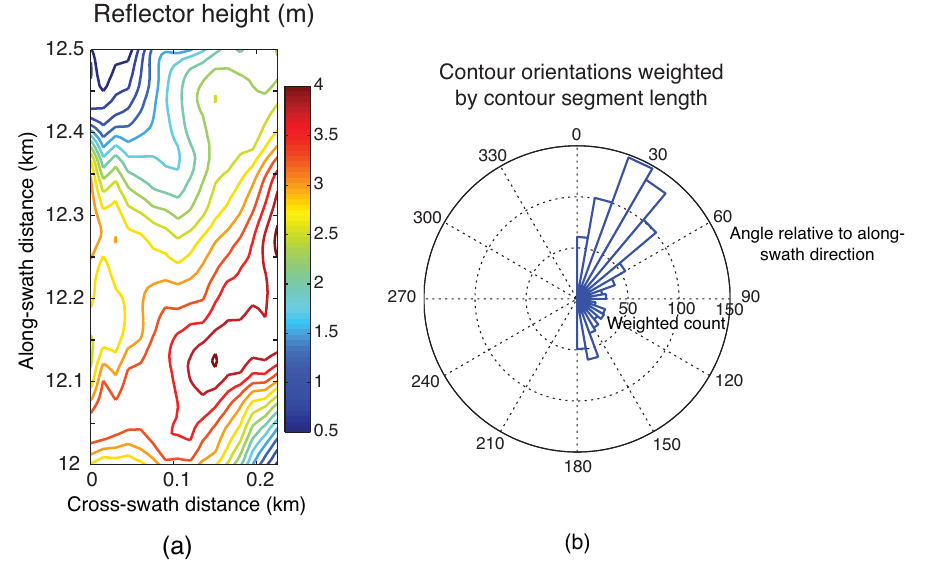
Fig. 7. Reflection peak/trough orientation relative to the swath can be obtained from a topographic contour plot of tracked reflections such as those shown in Fig. 6. (a) Contour plot of reflection relief for a portion of reflection 2 (see Fig. 6). (b) Rose diagram showing orientations of contour line segments relative to the along-swath direction. Histogram count has been weighted by contour line segment length.